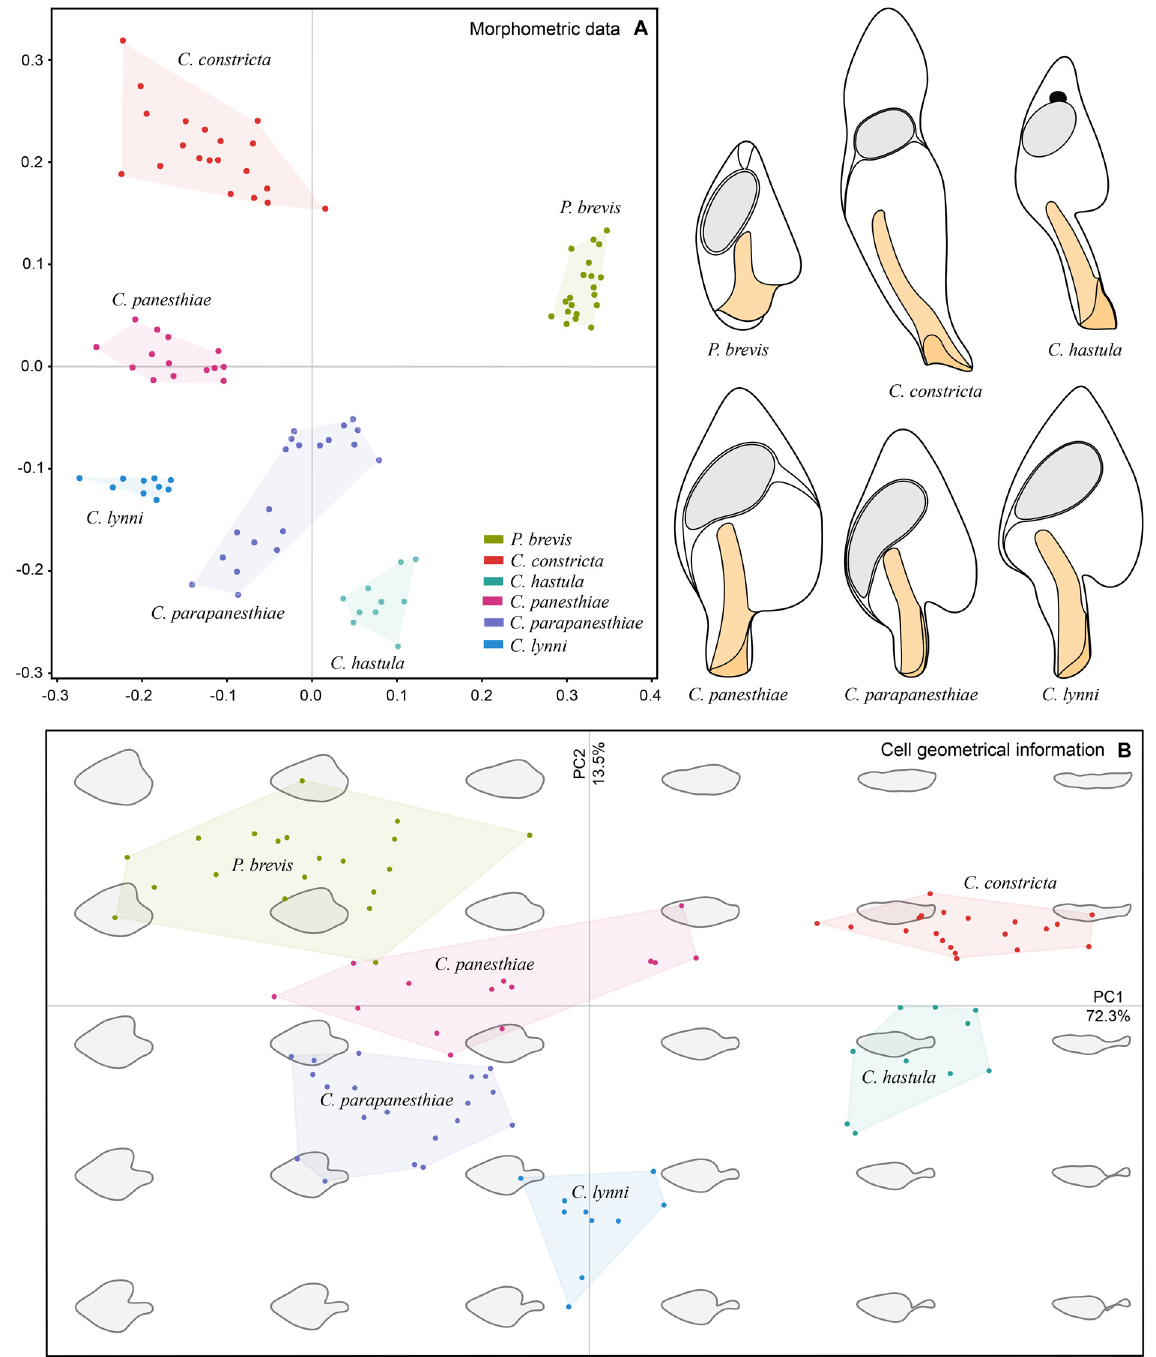
Fig. 16. Ordination analyses of 94 specimens of six clevelandellid morphospecies based on morphometric data (A) and cell shape information (B). A . Multidimensional scaling of the Gower’s similarity matrix. B . Principal component analysis of the Fourier coefficients. Eigenvalues of the first two ordination axes are λ = 0.723 and λ = 0.135, explaining 85.8% of the total variation. The morphometric and geometrical 1 2 data delimit the clevelandellid morphospecies consistently and unambiguously, i.e., each clevelandellid morphospecies forms a homogeneous cluster that is well isolated from all other morphospecies analyzed. Members of each morphospecies are highlighted by the same color as in Fig.